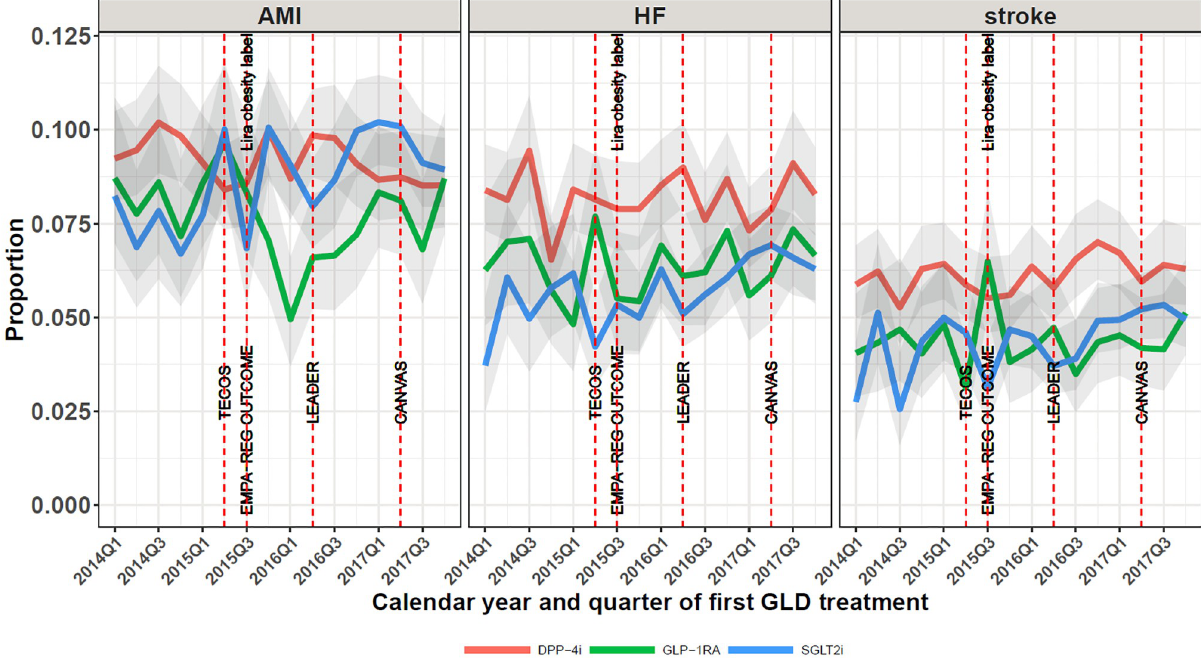
Fig 4. Time trends in patient proportions with acute myocardial infarction (AMI), heart failure (HF), or stroke at baseline. AMI: acute myocardial infarction; HF: heart failure; DPP-4i: dipeptidyl peptidase-4 inhibitor; GLP-1RA: glucagon-like peptide-1 receptor agonists; SGLT2i: sodium-glucose cotransporter 2 inhibitors; TECOS: Sitagliptin (DPP-4i) showed non-inferiority to placebo [35]; Lira obesity label: Liraglutide 3 mg launched as treatment for obesity; EMPA-REG OUTCOME: empagliflozin showed CV and CV/all-cause mortality benefits [10], LEADER: liraglutide showed CV and CV/all-cause mortality benefits [12]; CANVAS: canagliflozin showed CV benefits [11].